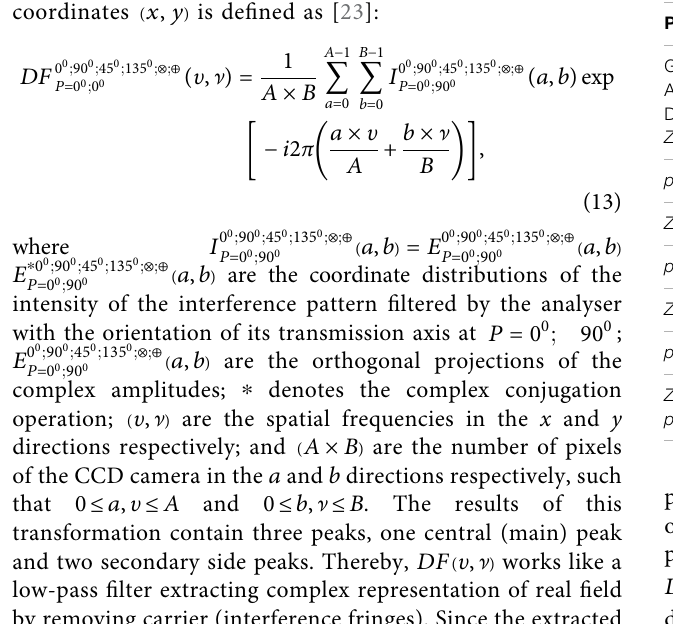
TABLE 1 | Optical, geometrical and statistical parameters of the myocardium histological sections